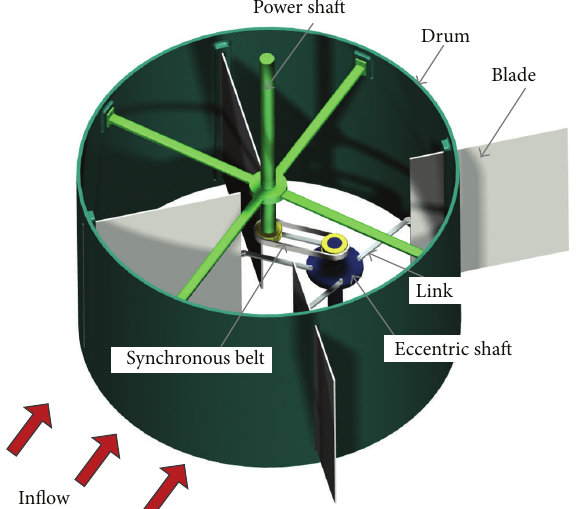
Figure 2: VAT with retractable